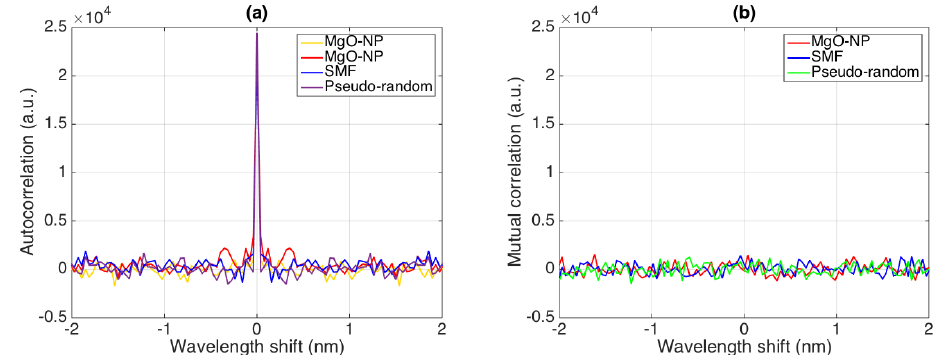
Figure A4. ( a ) Autocorrelation of scattering trace of 2 MgO-NO fibers, one SMF fiber, and a pseudo-random Gaussian process; ( b ) mutual correlation between the first MgO-NO signatures and the other MgO-NP, SMF, and pseudo-random